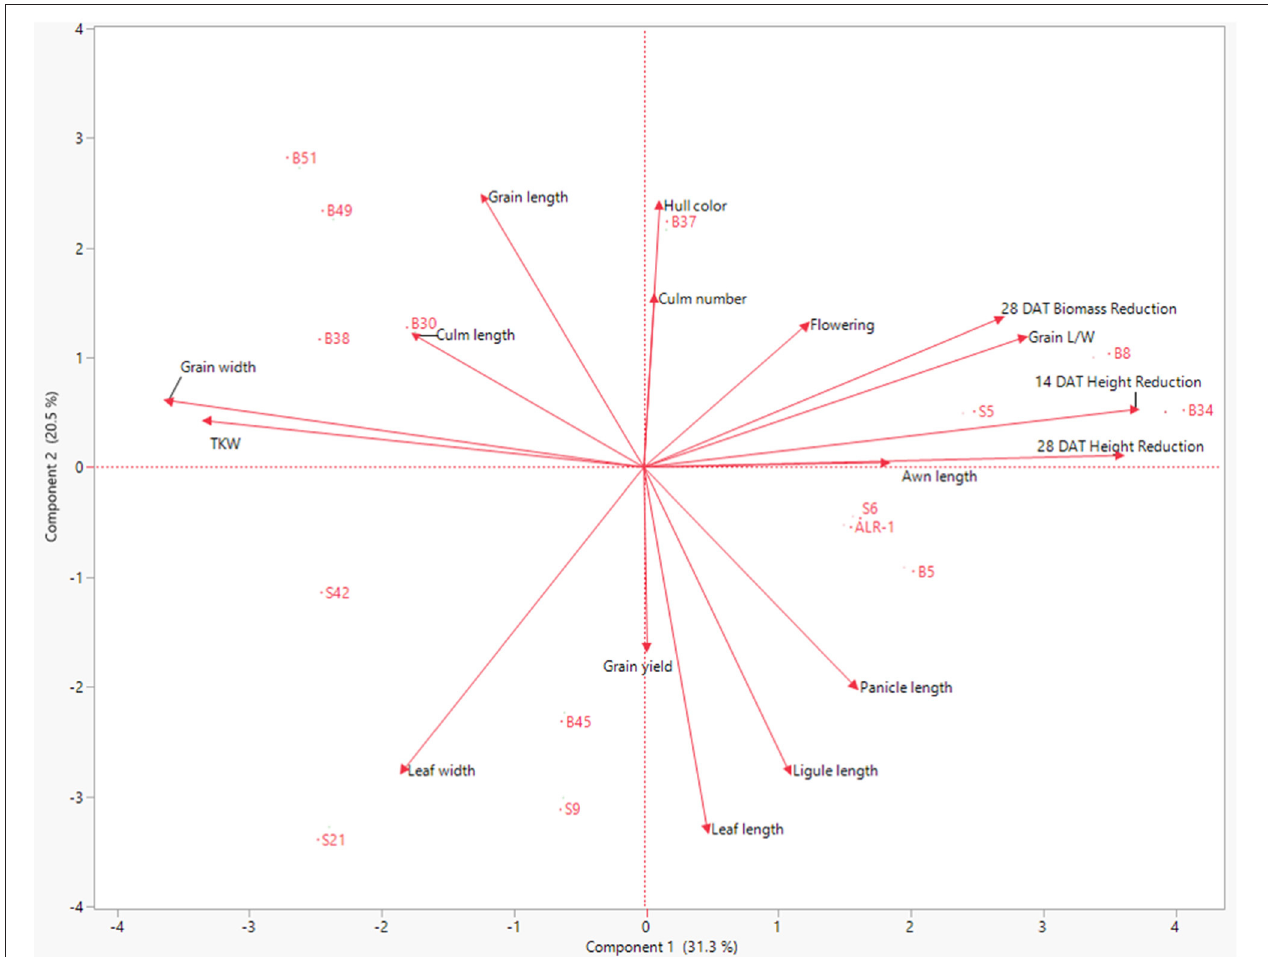
FIGURE 8 | Principal component analysis (PCA) of 16 agronomic traits plus plant height reduction 28 days after complete submergence stress treatment and plant biomass reduction 28 days after complete submergence stress